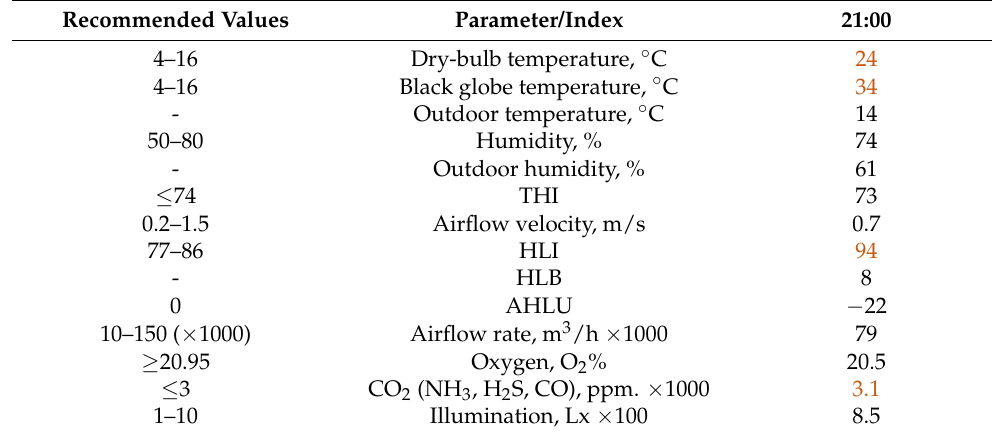
Table 8. Microclimatic conditions and indices at 21:00.